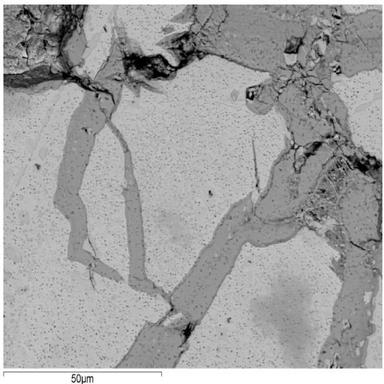
High magnification detail of the intermediate region microstructure, region 2 in